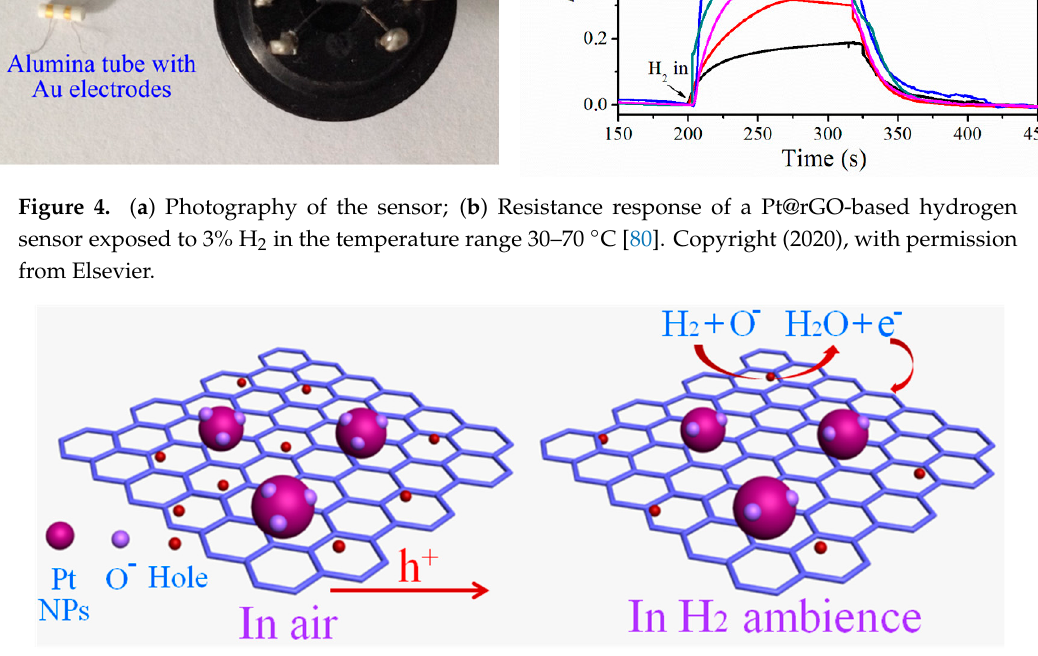
Figure 5. Sensing mechanism of the Pt@rGO nanocomposite sensor toward hydrogen [80]. Copyright (2020), with permission from Elsevier.